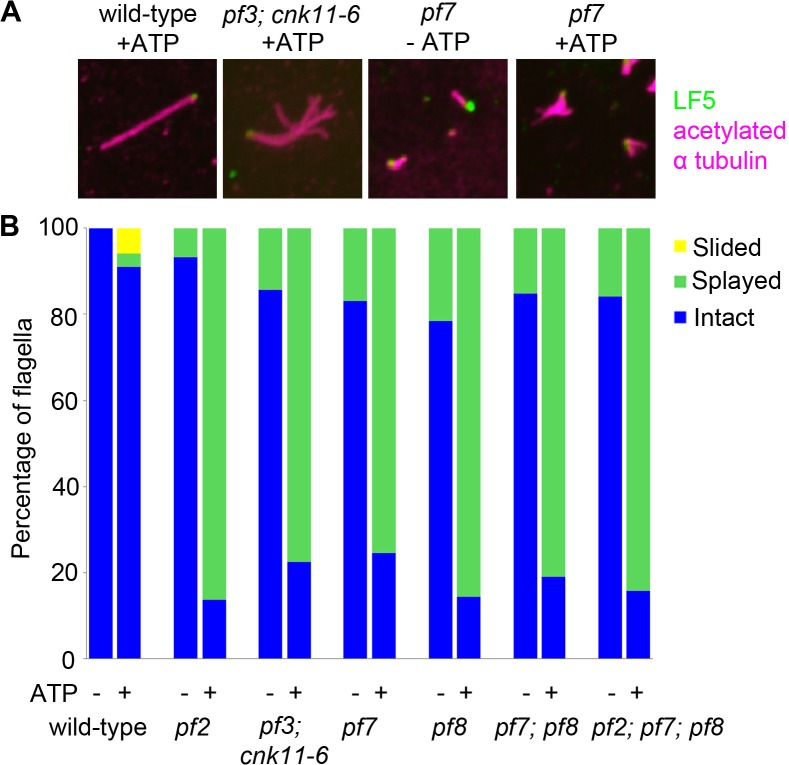
The pf7 and pf8 mutants show splaying phenotype in isolated axonemes similar to splaying in N-DRC mutants.(A) Fixed axonemes were stained with antibodies against LF5 (green) and acetylated α-tubulin (magenta). (B) Axonemes were scored as intact (blue), sliding (yellow), or splaying (green). At least 100 axonemes were score for each strain.